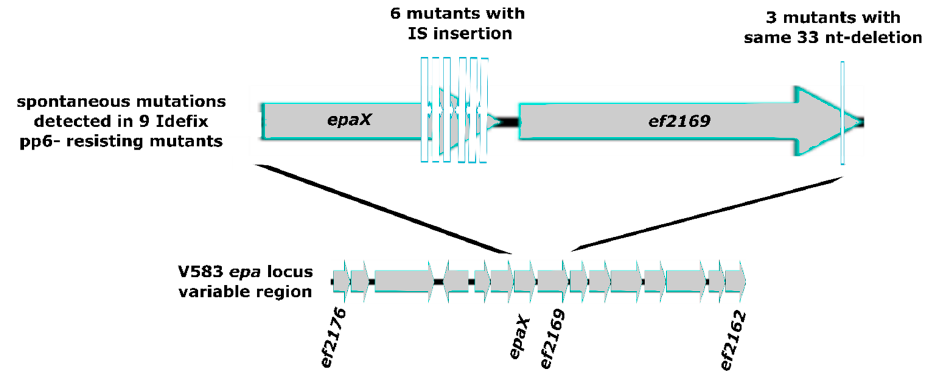
Figure 6. Genomic organization of V583 variable epa locus and focus on spontaneous mutations found in epaX region for nine Idefix pp6 - resisting mutants.